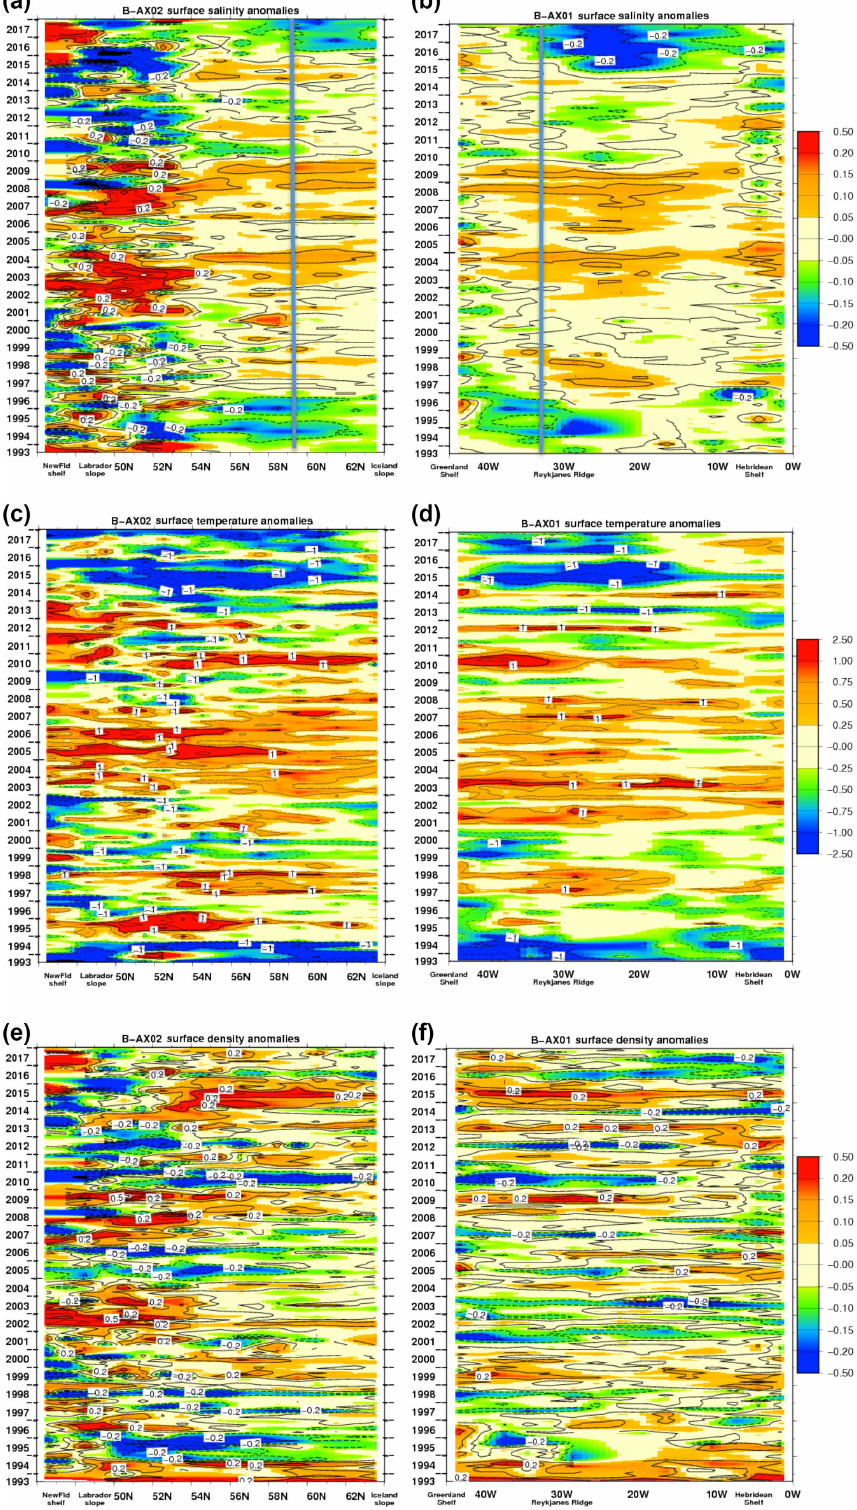
Figure 2. B-AX02 (a, c, e) and B-AX01 (b, d, f) Hoevmøller diagrams of deviations from an average seasonal cycle. Salinity (a, b) , temperature ( c, d , ◦ C), and density ( e, f , kgm − 3 ). Figure 1 indicates where the lines are located, and the vertical grey lines in the panels indicate where the two sections